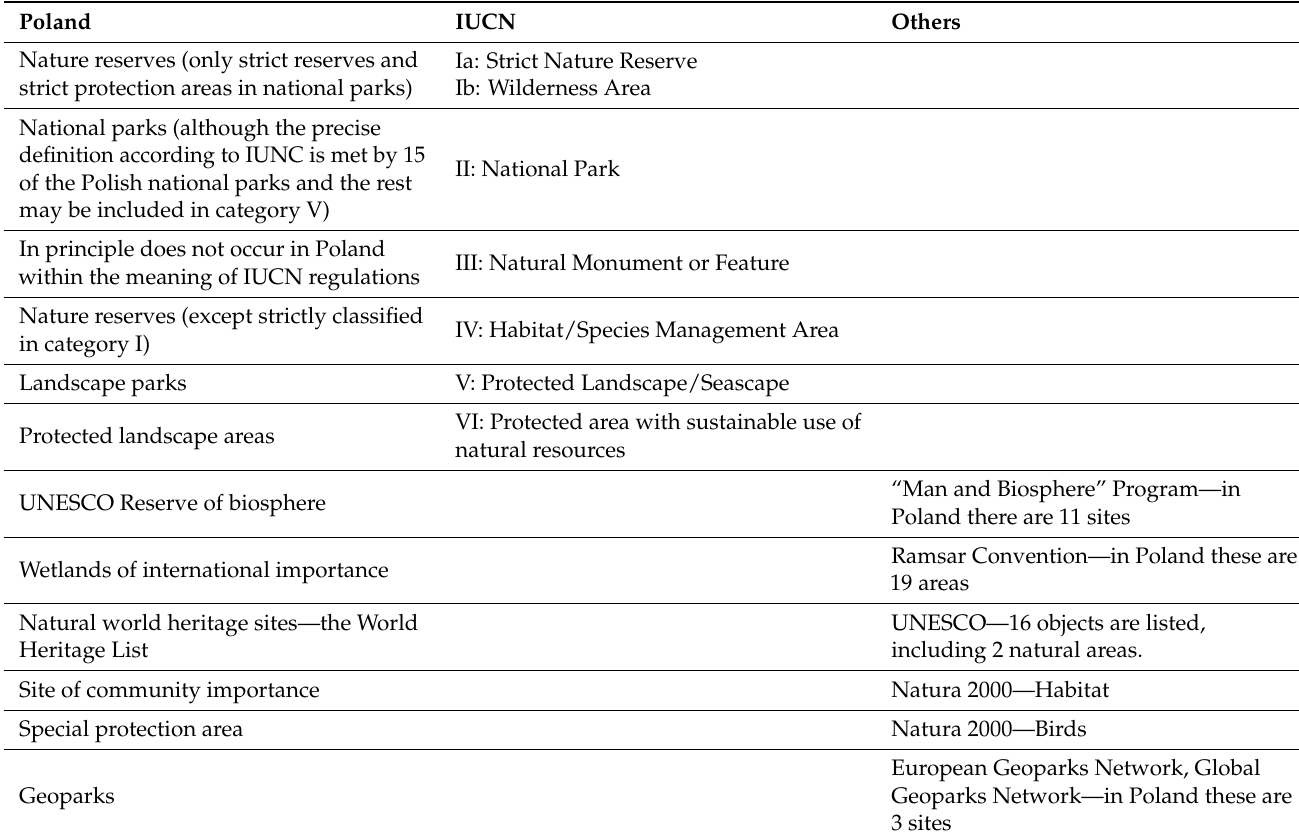
Table 2. Poland’s system of natural protected areas in the context of IUCN